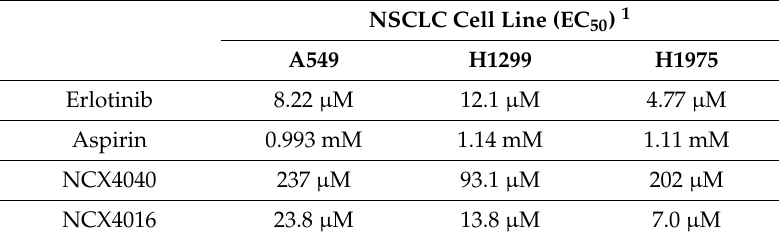
Table 2. Equipotent concentrations for erlotinib, aspirin, NCX4040, and NCX4016 in three NSCLC cell lines.